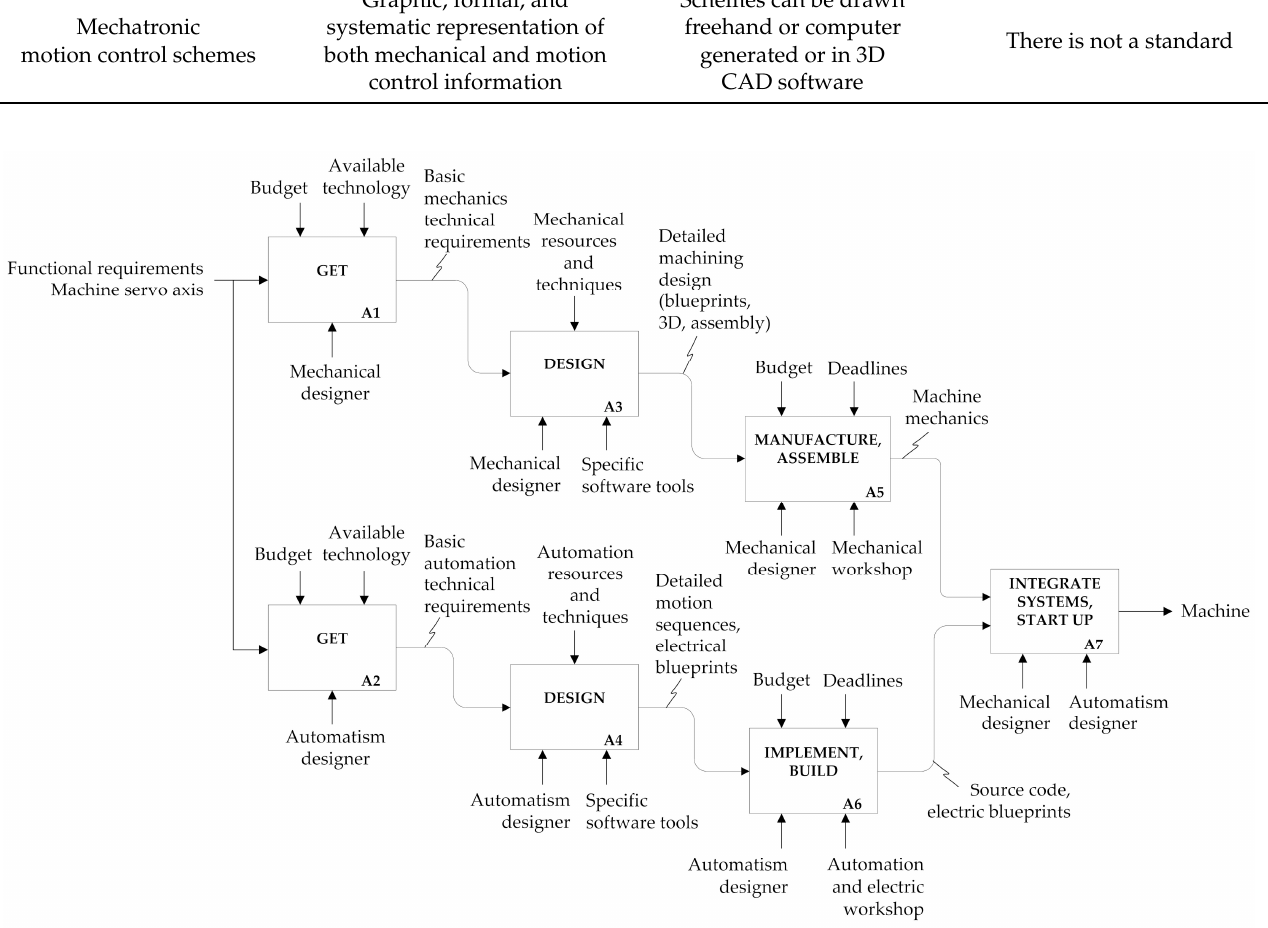
Figure 4. Servo axes machine design process.